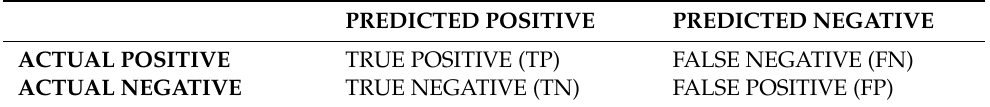
Table 3. The confusion